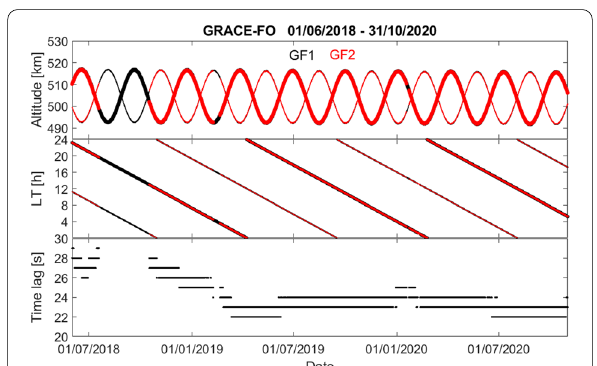
Fig. 1 The (top) altitude, (middle) LT coverage and (bottom) time lag between GF1 (black) and GF2 (red) when they fly over the geographic equator. The thicker and thinner lines represent the ascending and descending orbits, respectively. GF2 is plotted over GF1. The line is, therefore, black if GF2 data were not available